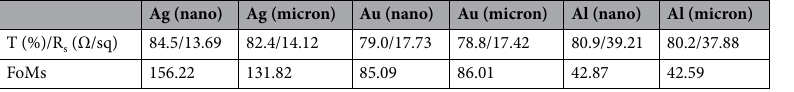
Table 1. Measured transmittance, sheet resistance, and FoMs of the nano/micron plasmonic